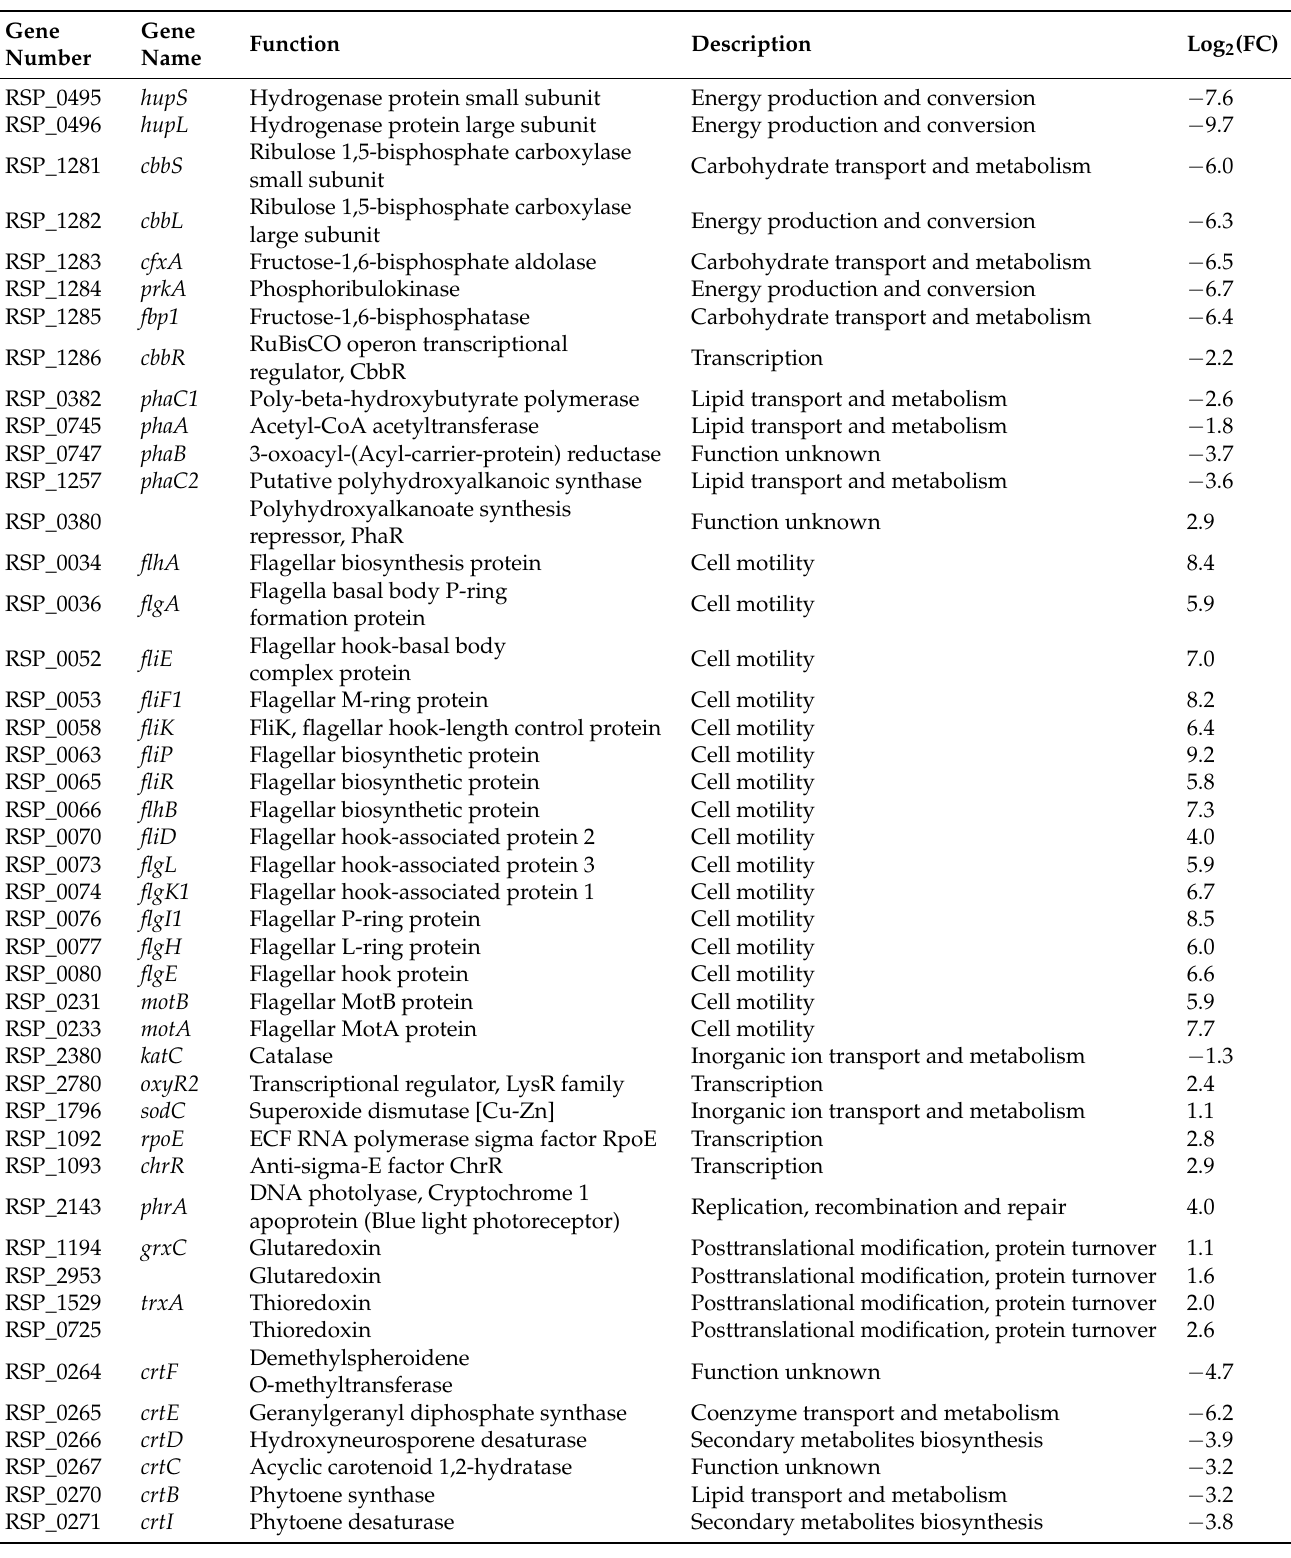
Table 1. Comparison of transcript levels in MES conditions versus normal photoautotrophic